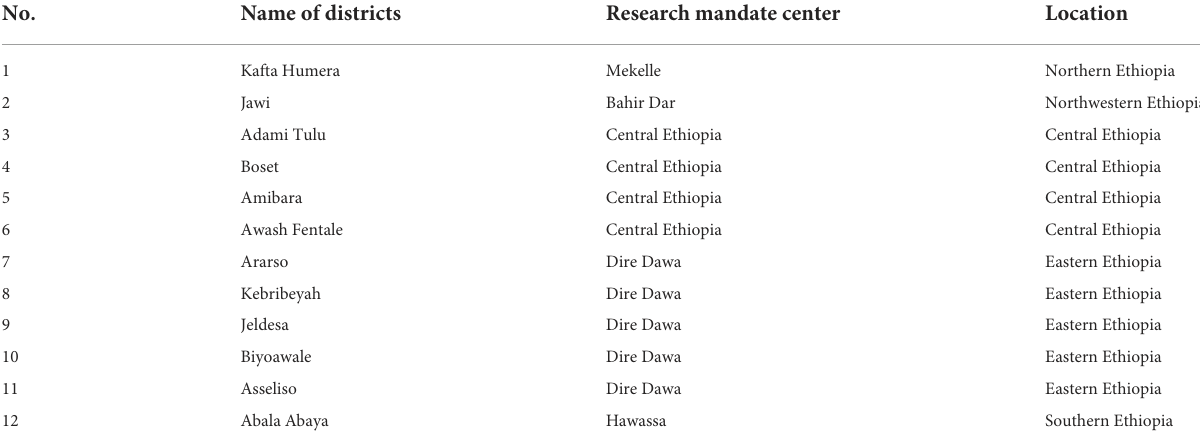
TABLE 1 List of sample surveyed districts taken from four research mandates of dryland areas.